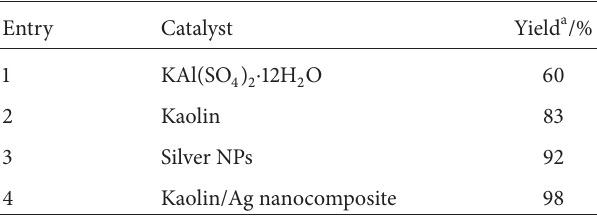
Table 4: Effect of the solvent on the synthesis of 4a by Kaolin/Ag nanocomposite catalyst.